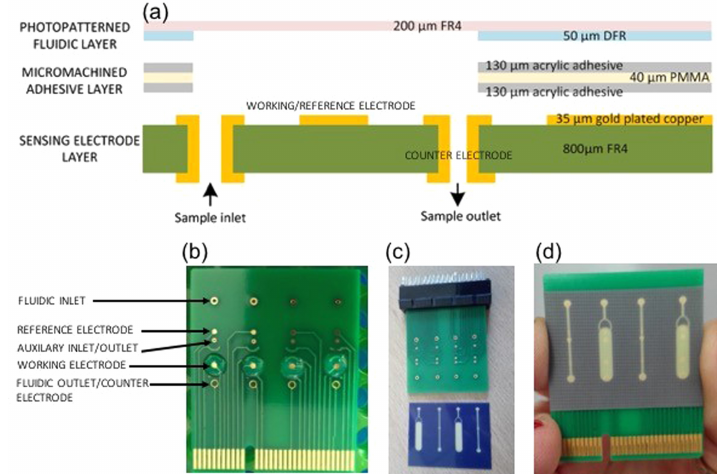
Figure 16. The exploited Lab-on-PCB biosensing platform: ( a ) integrated Lab-on-PCB stack-up; ( b ) Electrochemical Impedance Spectroscopy electrode configuration; ( c ) commercially fabricated PCB biosensing platform; ( d ) sample delivery microfluidics (reprinted from [206], copyright (2019), with permission from